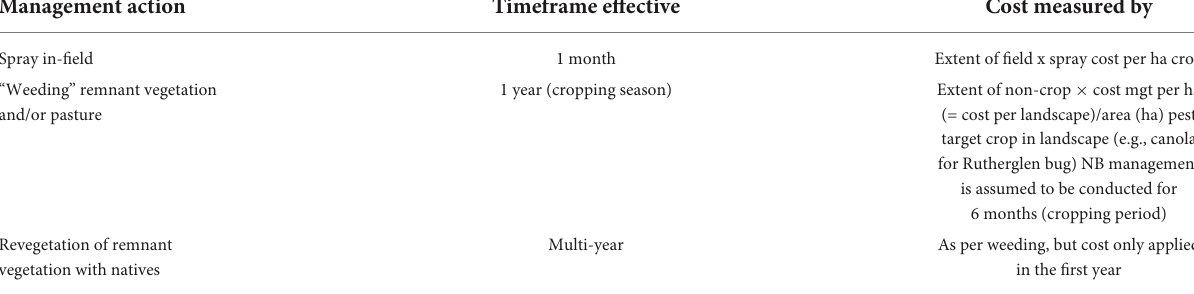
TABLE 2 Spatio-temporal scales at which costs and benefits of management actions are measured in the